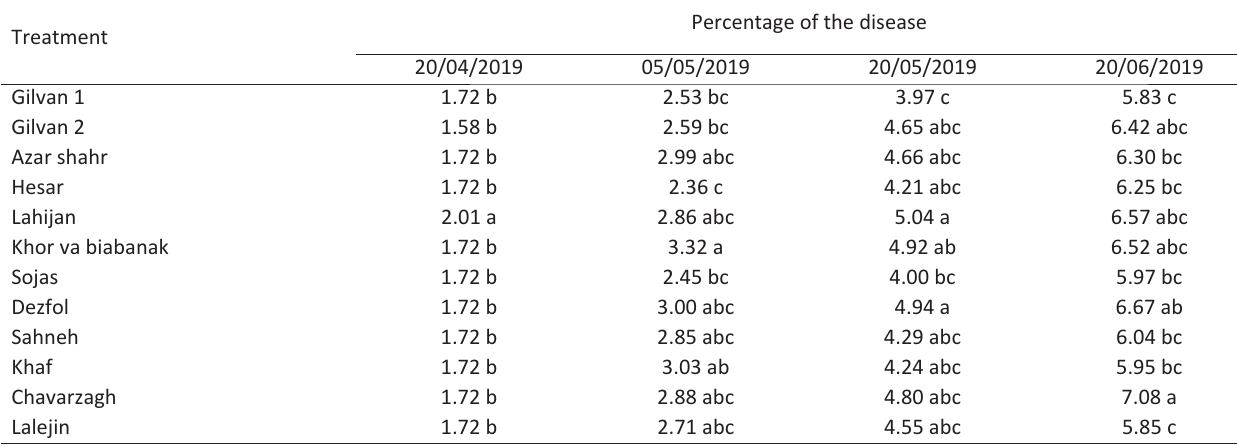
In each column different letters mean significant differences between samples.